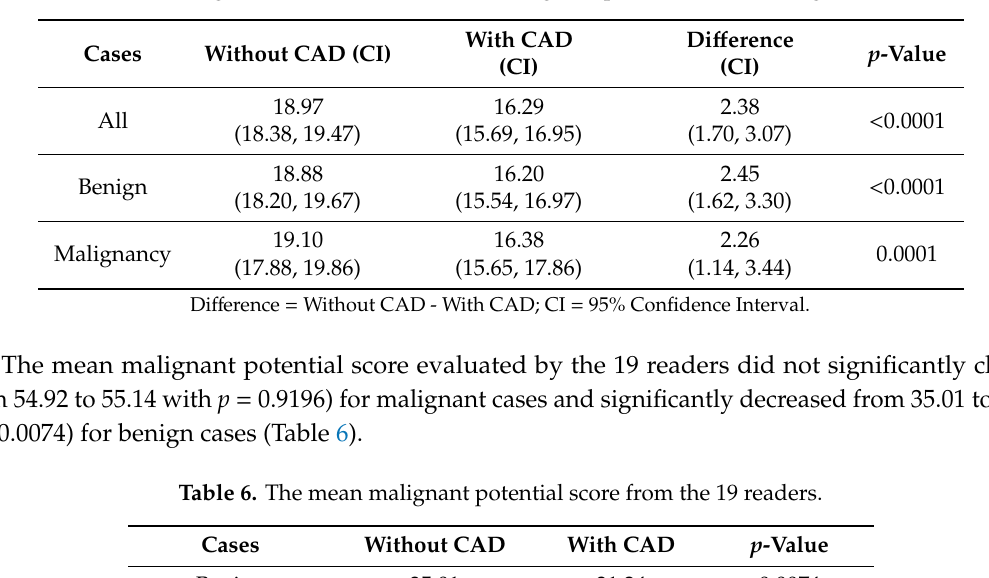
Table 5. The average standard deviation of the malignant potential score among the 19 readers.